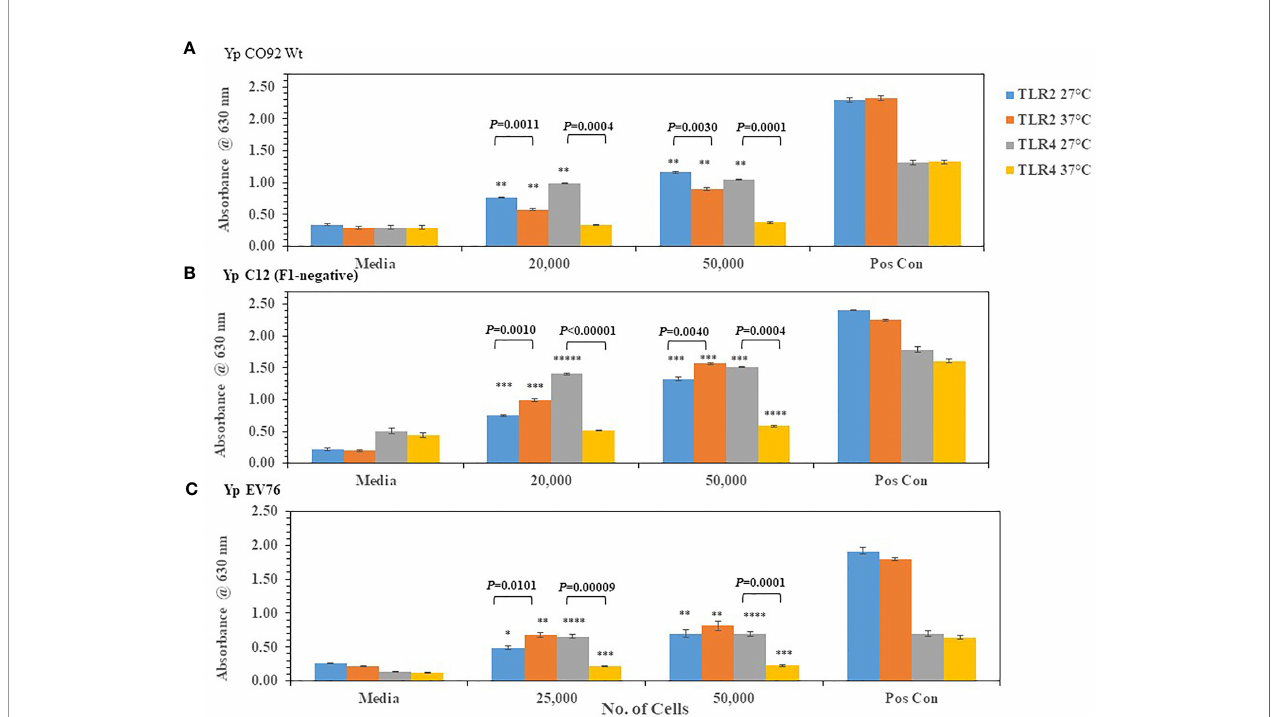
FIGURE 2 | Y. pestis ( Yp ) can modulate the activation of TLR4 depending on its growth temperature. Strains of Yp were grown at 27 − 28°C or 37°C and suspended in PBS. Different amounts of cells were added to HEK293-TLR2 or -TLR4 cells to evaluate their ability to activate the TLRs. Yp strains used: (A) Yp CO92, wild-type; (B) Yp C12, a F1- or capsule negative strain; (C) Yp EV76, a vaccine strain;. Media controls contained only PBS, and positive controls contained either HKLM cells (2 x 10 6 cells) for TLR2 or E. coli LPS (0.2 ng) for TLR4. All samples were analyzed in triplicate, and results represent one of two independent repeats. Results are presented as geometric mean with standard error of the mean. Signi fi cant differences between values at different temperatures are shown above the results. Signi fi cant values compared to media control are shown: * P ≤ 0.05; ** P ≤ 0.01; *** P ≤ 0.001; **** P ≤ 0.0001; ***** P ≤